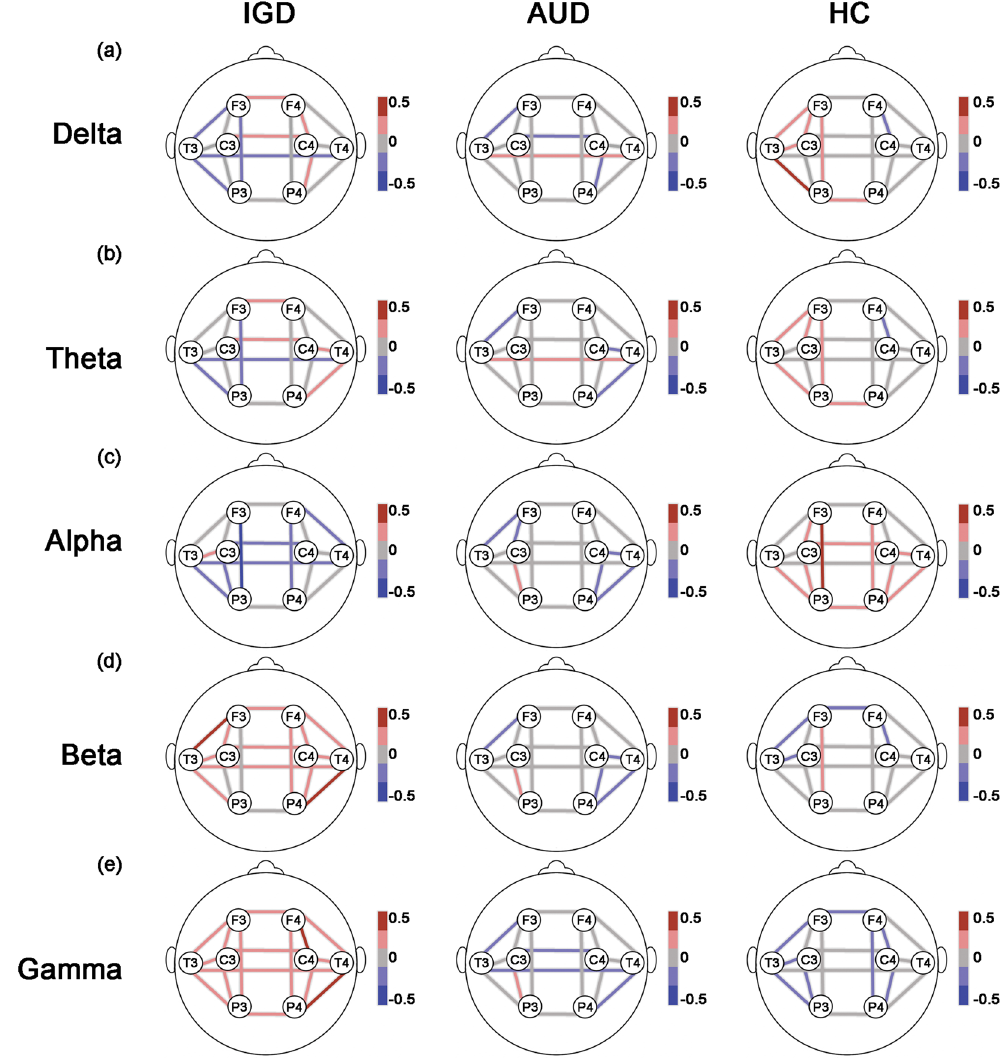
Figure 2. Coherence with controlling effects of psychological covariates. The lines represent estimated coherence means of the groups by GEE at each location for the ( a ) delta, ( b ) theta, ( c ) alpha, ( d ) beta, and ( e ) gamma bands. Both effects of demographic data (age, education, and IQ) and psychological data (scores on the BDI-II, BAI, and BIS-11) were controlled in analyses. The meaning of bar scales ranging from − 0.5 (blue) to 0.5 (red). Fisher’s Z-transformed scores were used for the EEG data. IGD = Internet gaming disorder; AUD = alcohol use disorder; HC = healthy control; GEE = generalized estimating model; EEG = electroencephalography; IQ = intelligence quotient; BDI-II = Beck Depression Inventory-II; BAI = Beck Anxiety Inventory; and BIS-11 = Barratt Impulsivity